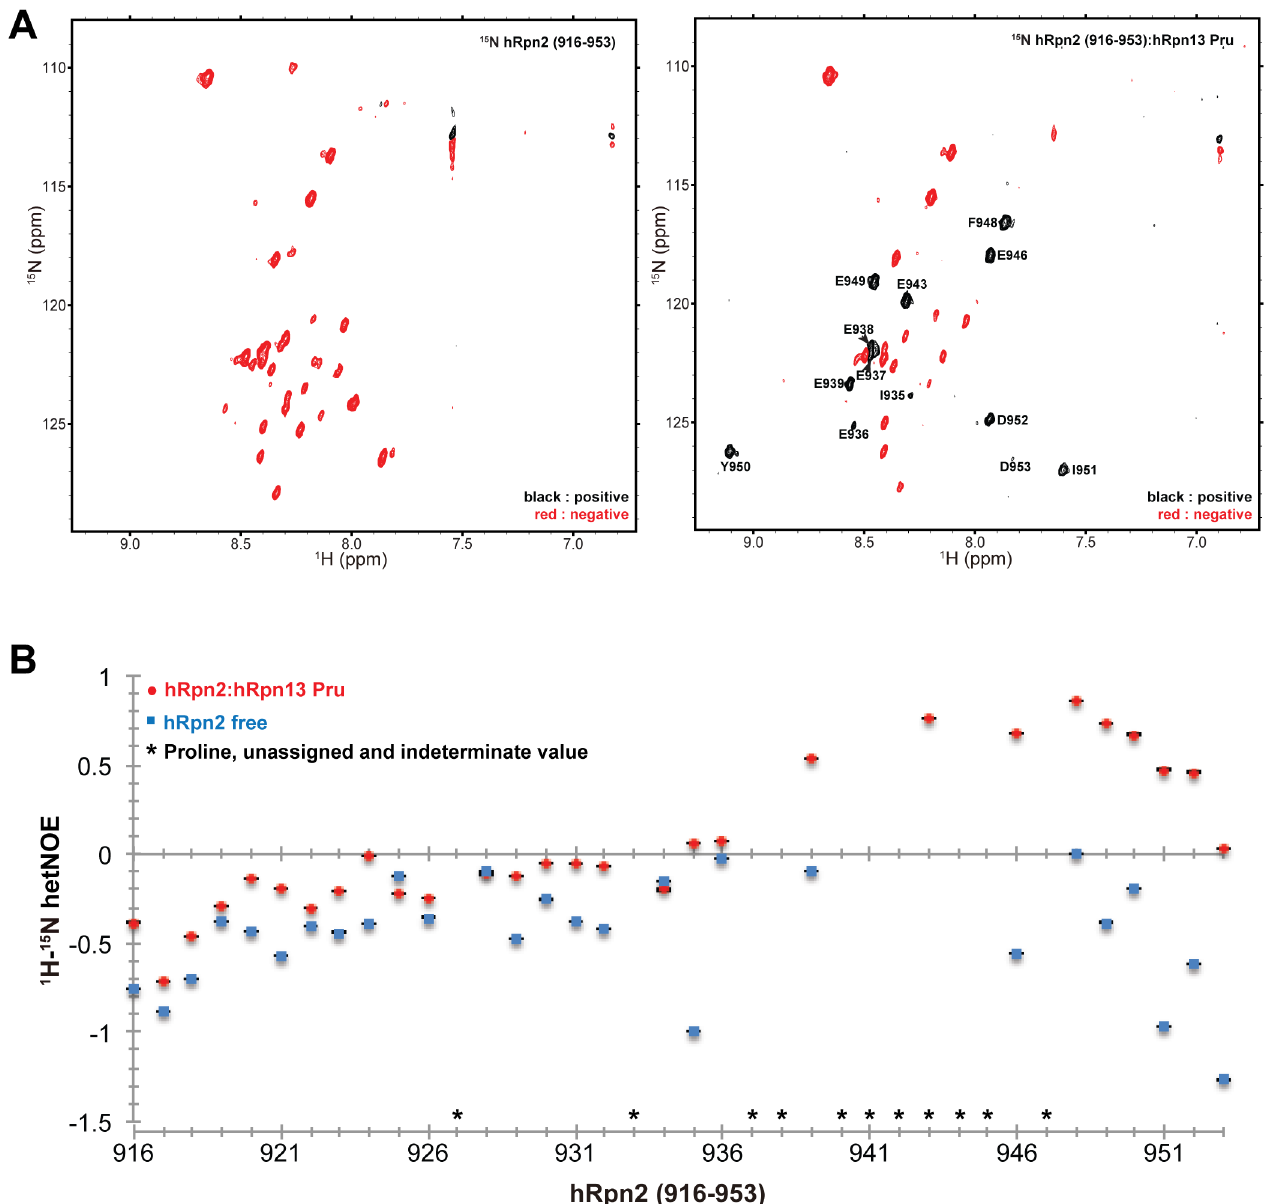
Fig 4. Highly dynamic hRpn2 (916 – 953) becomes ordered at the C-terminal region upon binding to hRpn13 Pru. (A) 1 H- 15 N heteronuclear NOE spectra of hRpn2 (916 – 953) (left) and bound to hRpn13 Pru domain (right). Positive and negative signals are black and red, respectively. (B) Plots of heteronuclear NOE enhancement values (hetNOE) for hRpn2 (916 – 953) (blue squares) and hRpn2 (916 – 953):hRpn13 Pru (red circles). Prolines, unassigned residues (Q940 and E941), and those with too much overlap for reliable integration are indicated by asterisks. Error bars are small and indicated, as calculated by using